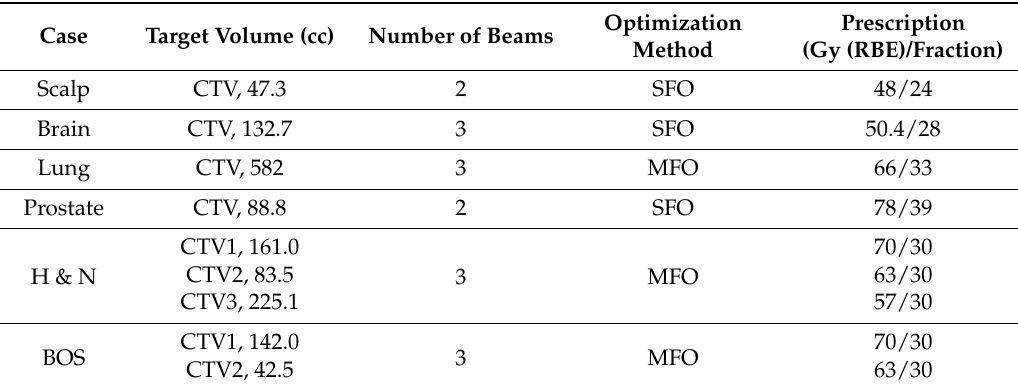
Table 5. Treatment planning information for the cases selected for this